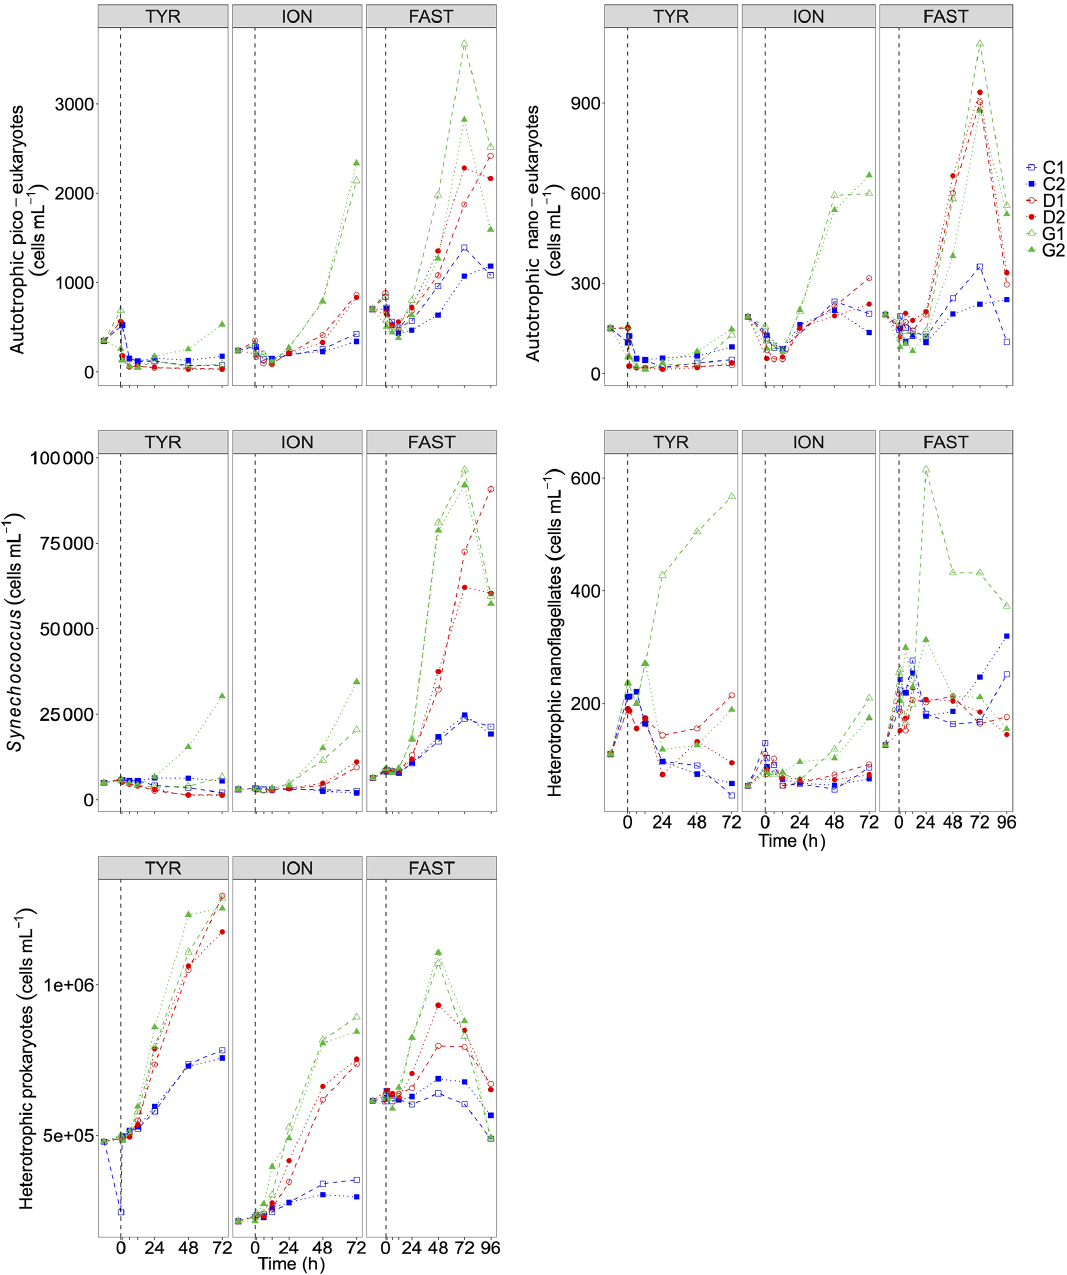
Figure 8. Abundance of autotrophic pico-eukaryotes, autotrophic nano-eukaryotes, Synechococcus, heterotrophic prokaryotes (HP), and het- erotrophic nano-flagellates (HNF), measured by flow cytometry, in each tank during the experiments at TYR, ION and FAST. The evolution of autotrophic biomass (see Material and methods for details on the calculation) is also shown. The dashed vertical line indicates the time of seeding (after